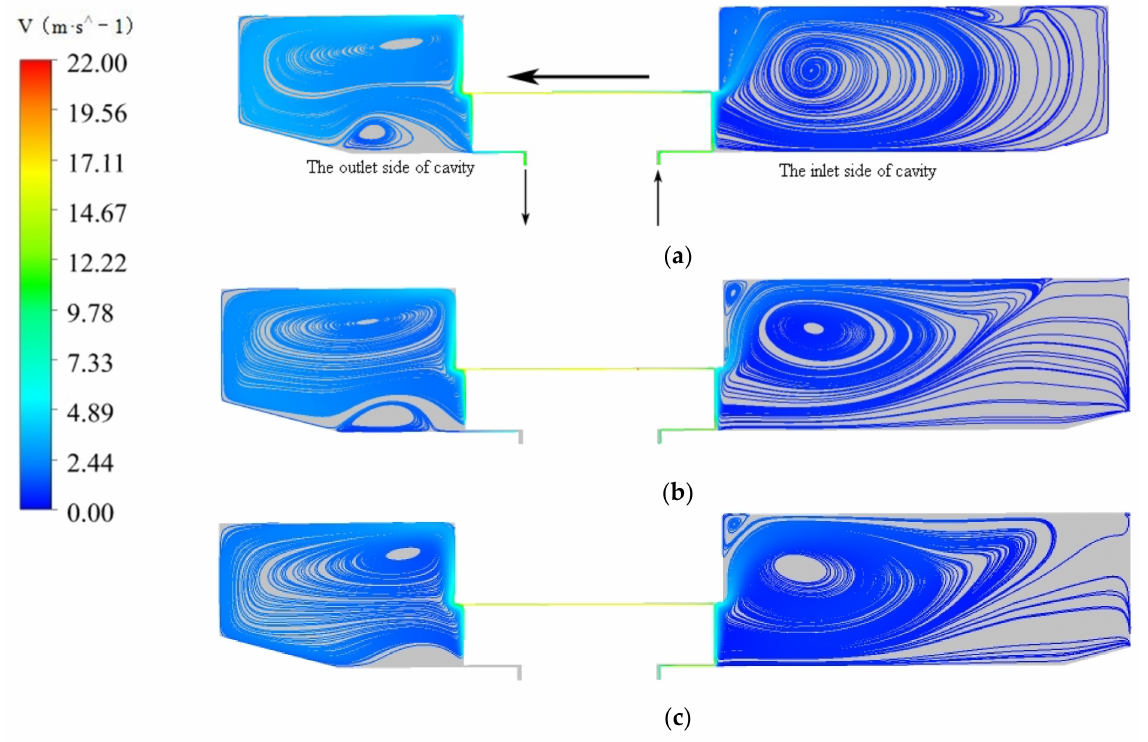
Figure 14. The sectional velocity streamline of the stator–rotor cavity. ( a ) 0.78 Q d , ( b ) Q d , ( c ) 1.17 Q d .